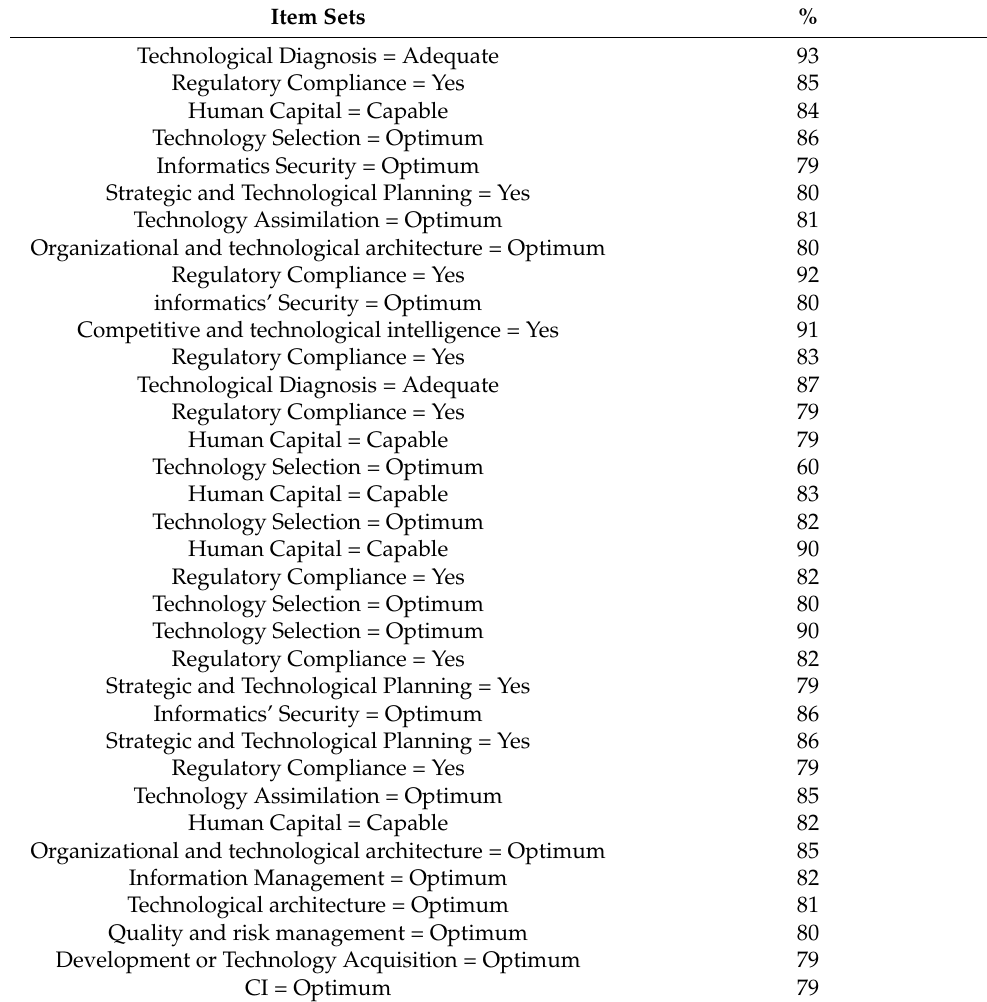
Table 5. Sets of